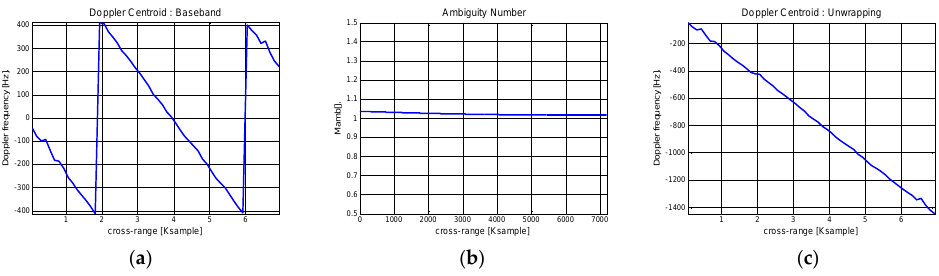
Figure 11. Doppler centroid estimation of Boeing 747 ISAR data: ( a ) ACCC based Doppler history estimation; ( b ) Ambiguity number estimation; ( c ) After phase unwrapping. Target velocity can be derived from the range trajectory and Doppler centroid. Initially, the velocity is calculated from the range trajectory. Then the best fitting model is coarsely estimated through RANSAC fitting. The results are compared in Figure 12a.There are found disturbance errors across the azimuth time that should be corrected to enhance the image quality. To elaborate the evaluation and attain a refined result, autofocusing scheme is applied to the coarse velocity estimation.